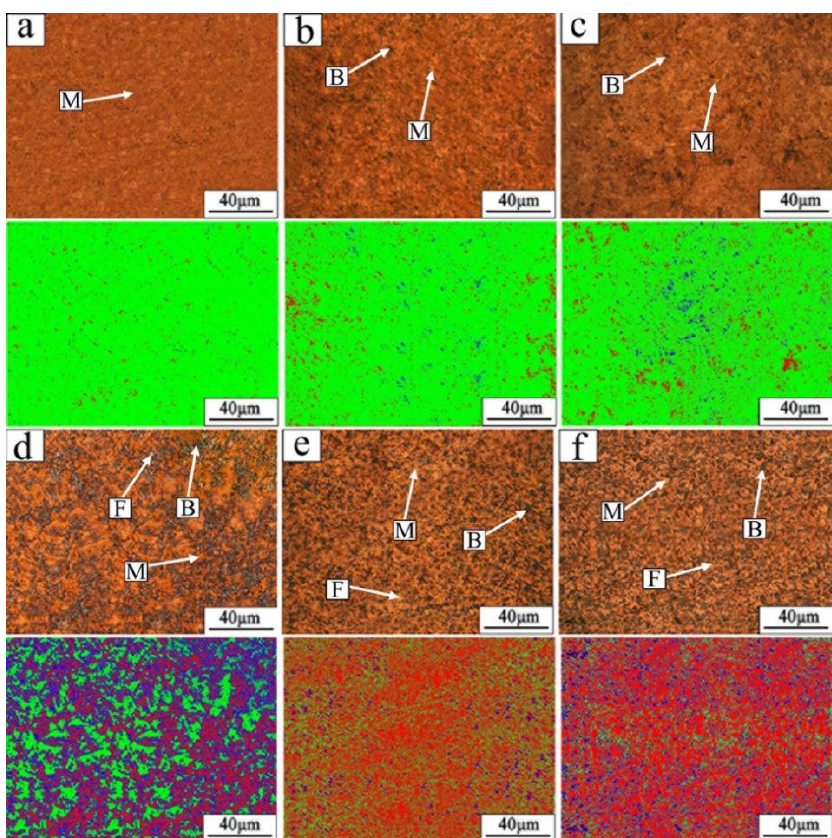
Figure 5. Two-stage color tint etched optical micrographs and manually identified microstructure images ( a ) 25 C; ( b ) 600 C; ( c ) 200 H; ( d ) 400 H; ( e ) 500 H; ( f ) 600 H. C represents the cold zone and H is the hot zone.